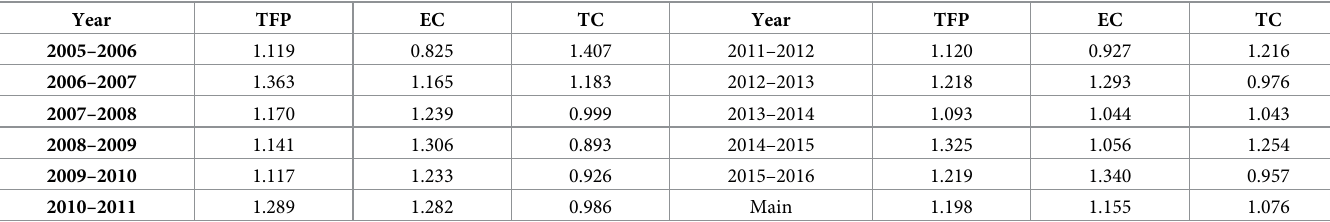
Table 5. Innovation efficiency and its decomposition